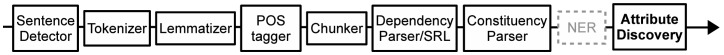
The cTAKES Pipeline.The SHARPn Polarity Module is an Attribute Discovery algorithm. Training and evaluations use gold standard NEs (skip NER).